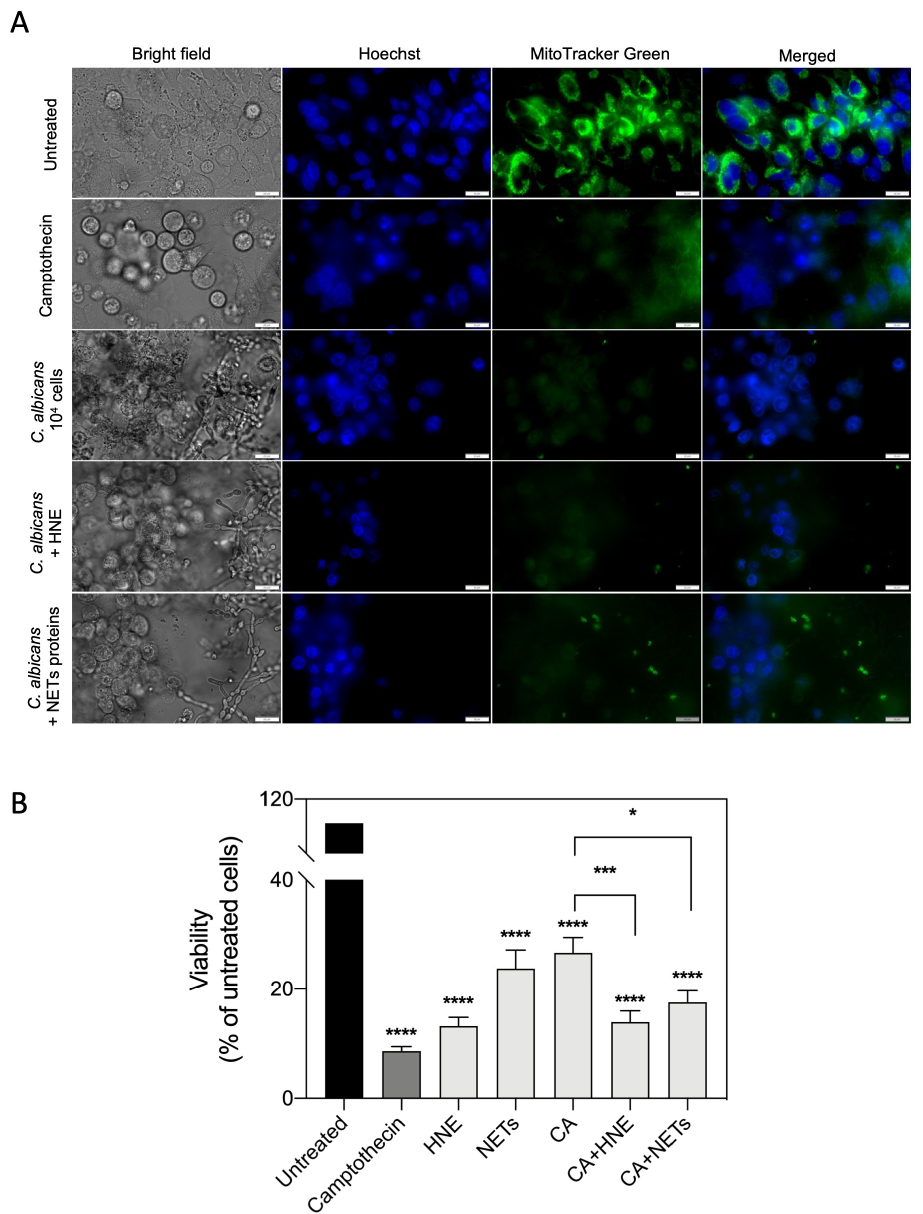
Figure 7. The influence of the binding of NET proteins to the C. albicans cell surface on the interactions with epithelial cells. C. albicans (10 6 cells/mL) cells were incubated with NET proteins (212 µ g/mL) and HNE (14 µ g/mL) for 1 h at 37 ◦ C, washed three times with PBS, and then added to a monolayer of A549 cells (10 4 cells/well). Unstimulated cells served as a negative control, and cells treated with camptothecin (CA, 7 µ M) were used as a positive control. The monolayers were incubated with all of the stimulants for 24 h at 37 ◦ C and 5% CO 2 . Then, the cells were washed, and the viability was assayed using MitoTracker™ Green FM dye. The cell nuclei were stained using Hoechst (dilution 1:1000). The cells were imaged using an Olympus IX73 microscope ( A ). Additionally, using the CellSens software, the mean gray value was determined for 30 representative cells ( B ). A representative result of three independent experiments is presented. In order to assess the significance between the samples, an ANOVA with Dunnett’s multiple comparisons post-hoc test was used. The results were considered statistically significant at p < 0.05 (* p ≤ 0.0332, *** p ≤ 0.0002, **** p < 0.0001).